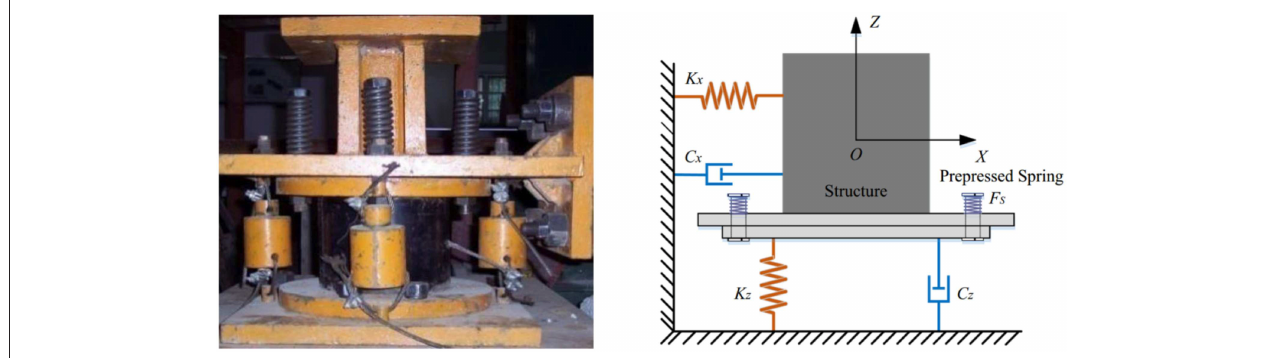
FIGURE 2 | The structural diagram and the mechanics model of MEIMD (Xu et al.,